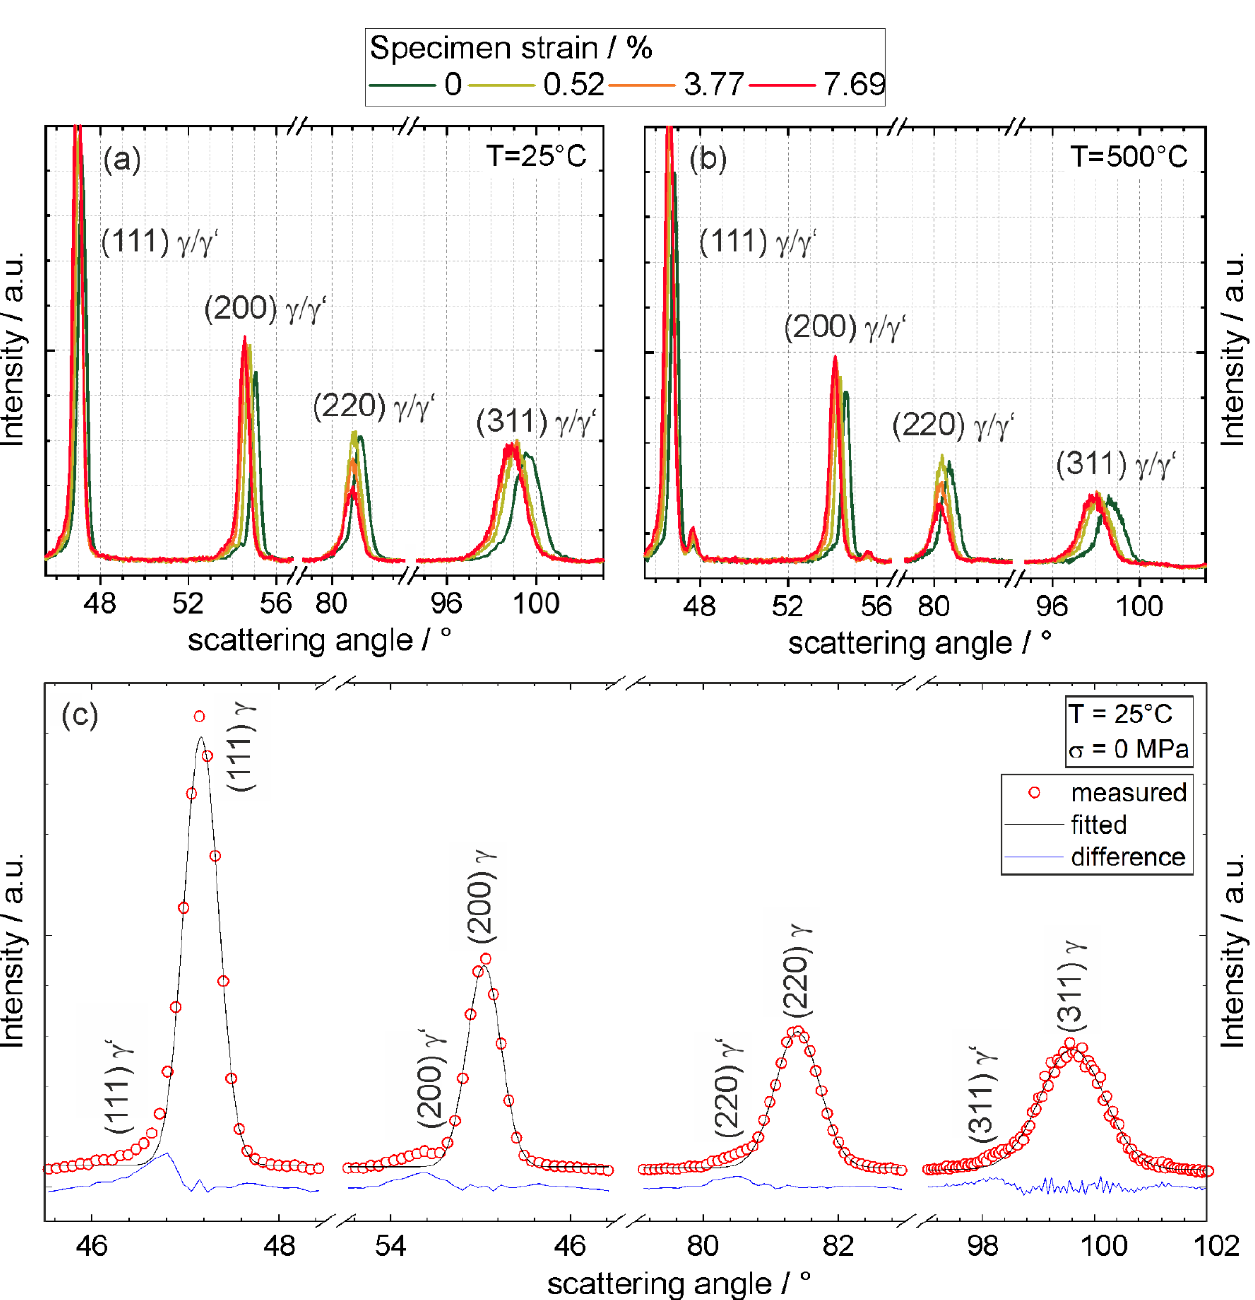
Figure 4. Neutron diffraction pattern at different specimen strains (0, 0.52, 3.77, and 7.69%) performed at ( a ) 25 °C and ( b ) 500 °C. The results of the Gaussian curve fitting of the individual peaks is exemplarily shown for the sample tested at 25 °C in the unloaded state (σ = 0 MPa) in ( c ).